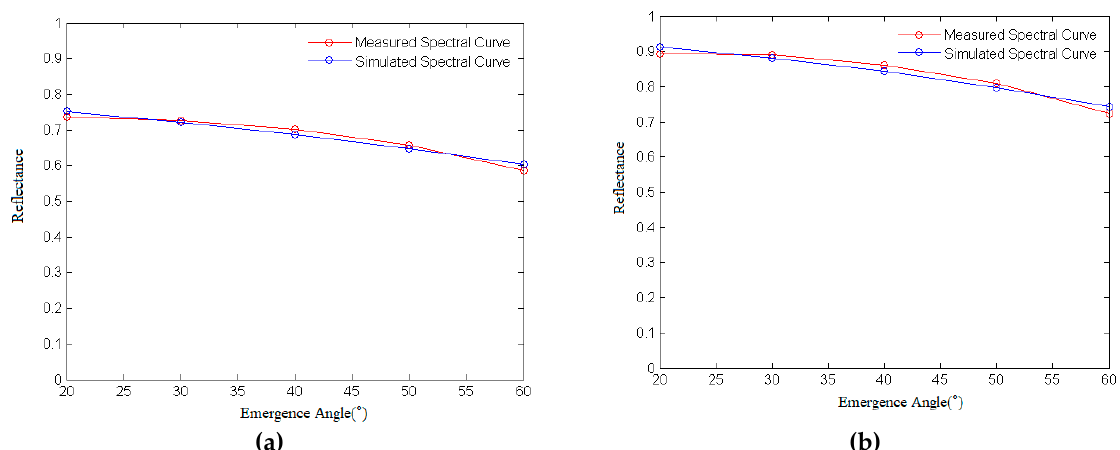
Figure 12. Comparison of the simulated and measured spectra of olivine at 0.57 µm ( a ) and 2.15 µm ( b ) as a function of angle.